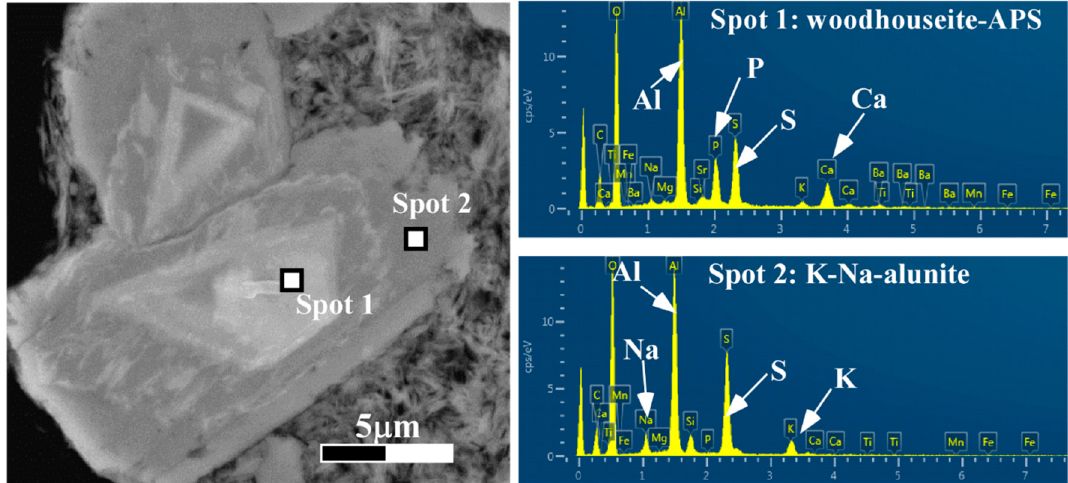
Figure 2. Typical energy dispersive X-ray (EDS) spectrum of aluminum-phosphate-sulfates (APS) mineral occurring as a core of alunite.